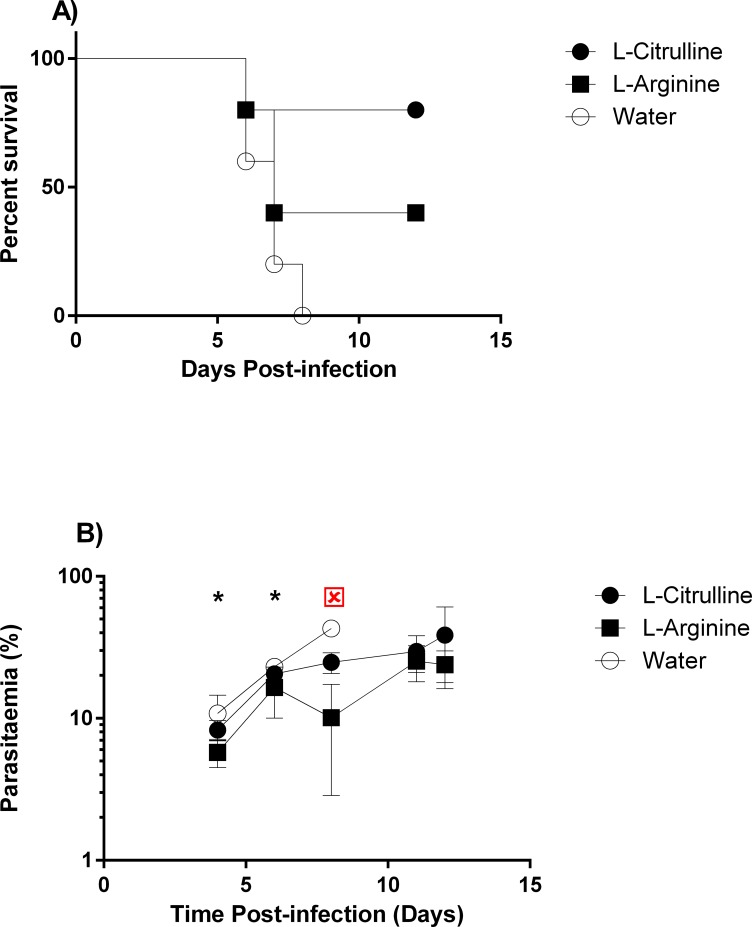
Both oral arginine and citrulline protect against eCM.Groups (n = 5) of mice were injected i.v. with PbA on day 0 PI and allowed to drink equimolar (731mM) arginine or citrulline ad libitum (~3ml/mouse). (A): survival, (B): parasitemia (mean % ± stderr) timecourse of arginine-, citrulline-, and water-treated mice infected with PbA. Citrulline; Arginine; Water. This experiment was repeated twice with similar results. In one replicate experiment, mice on arginine in drinking water exhibited significantly (p<0.05) lower parasitemia than water controls, but this effect was not consistently observed. : p<0.05 Arginine vs Water control;: p<0.05 Arginine vs Citrulline.